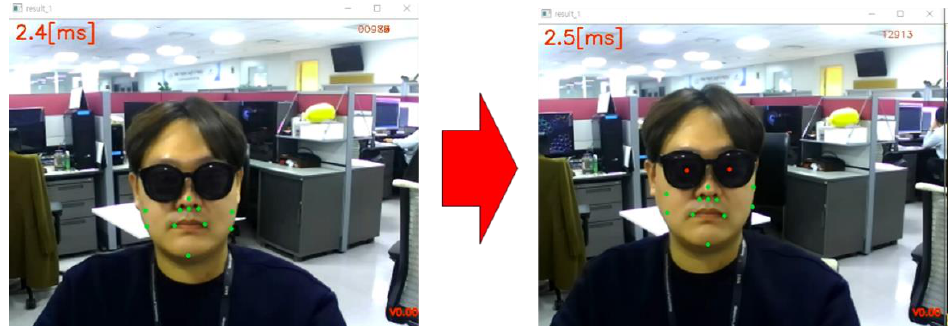
Figure 5. Eye position estimation by a supervised linear regression algorithm. Nonoccluded area shape tracking points (left, green dots), with eye positions inferred using these points (right, red dots).